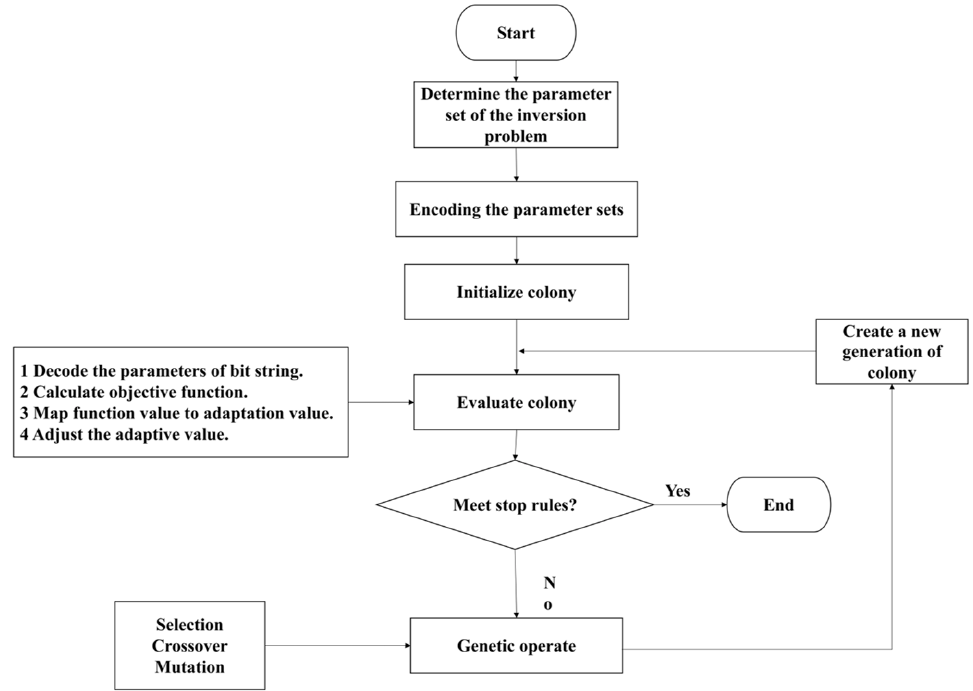
Figure 2. The flow chart of the genetic algorithm.